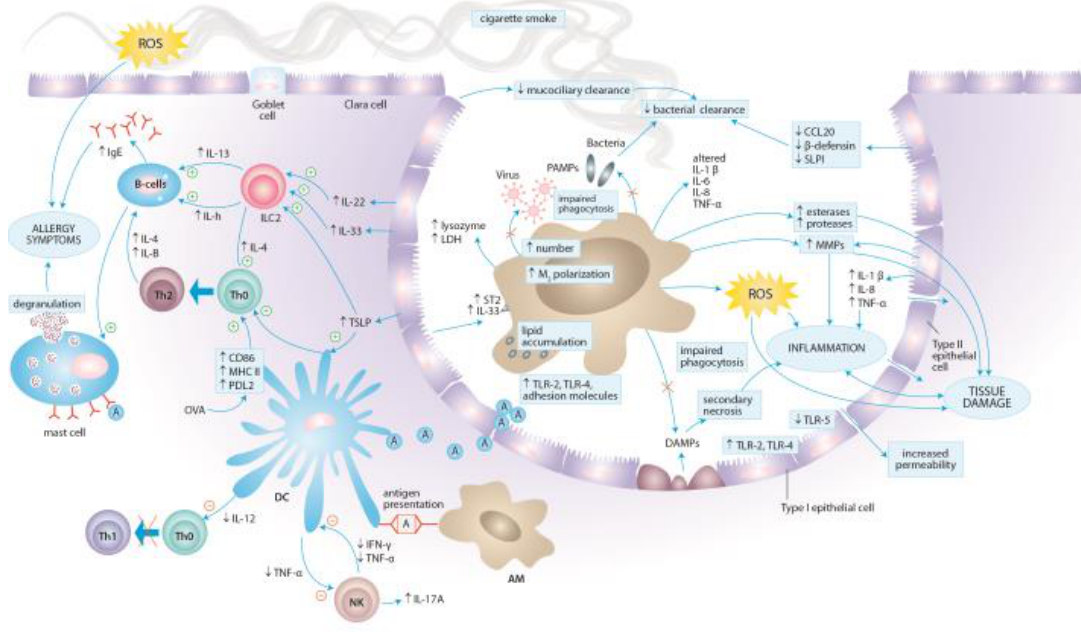
Figure 3. Local immune responses to cigarette smoke in the lung tissue.